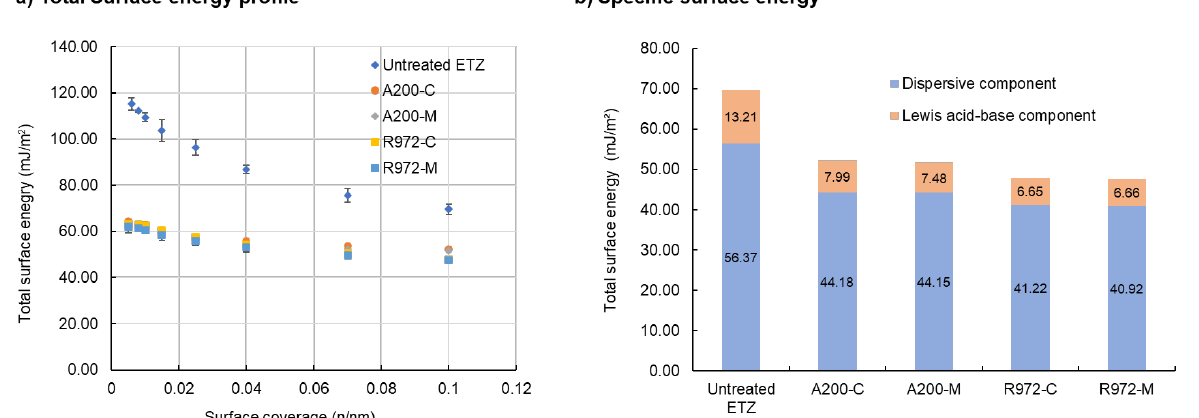
Figure 5. Effect of silica nanoparticle coating on the surface free energy of ETZ: ( a ) total surface free energies of ETZ powders and ( b ) proportions of dispersive and polar components of the surface free energies at 10% surface coverage (measured by inverse gas chromatography). In ( a ), the values are expressed as means ± standard deviations of the means ( n = 3).